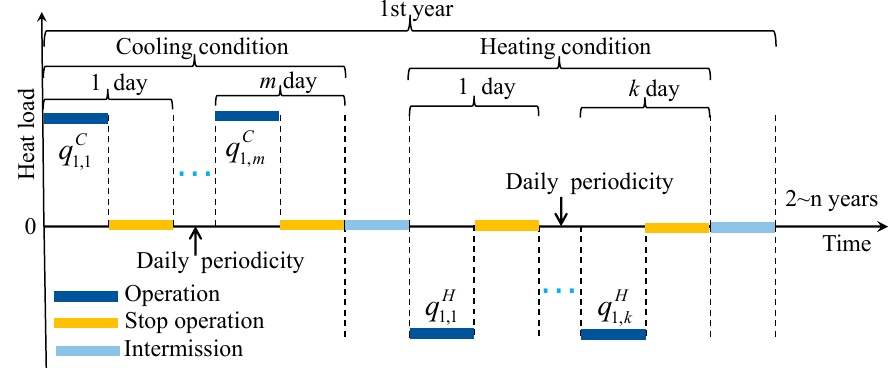
Figure 6. Simplified model of thermal load under typical intermittent operation condition.